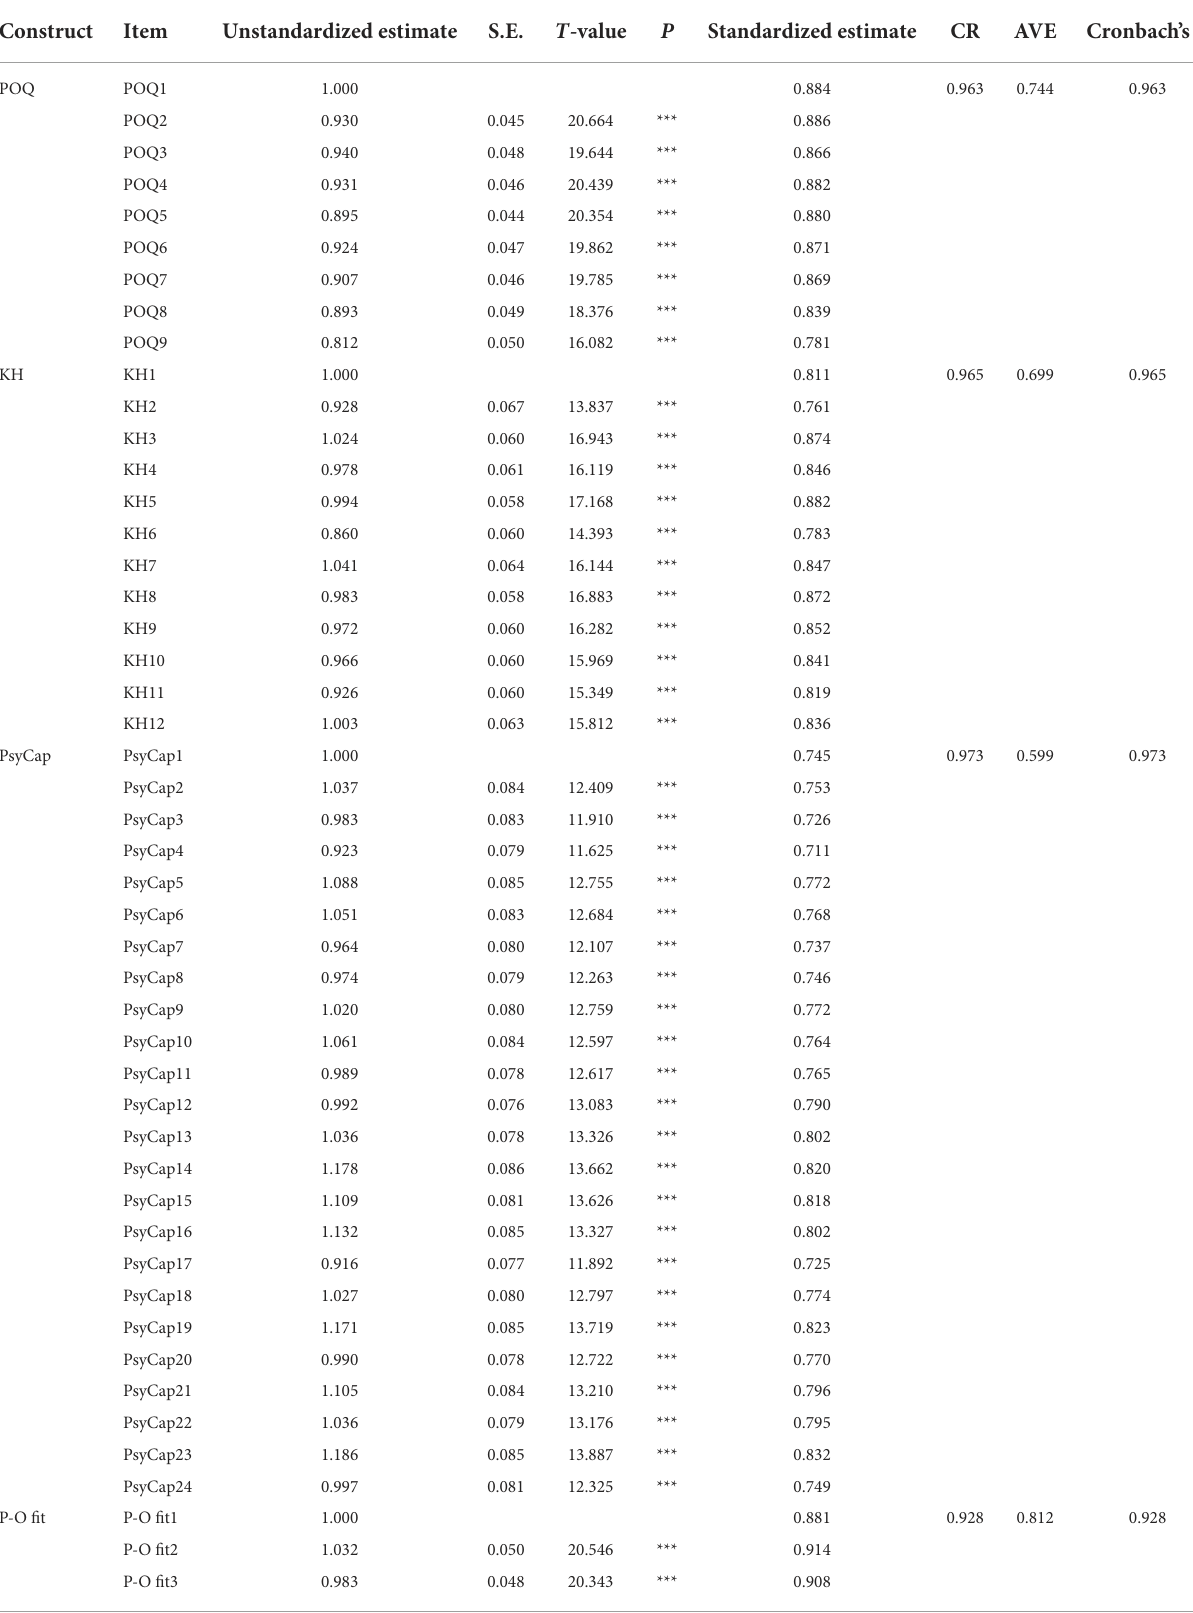
TABLE 2 Measurement model reliability and validity analysis